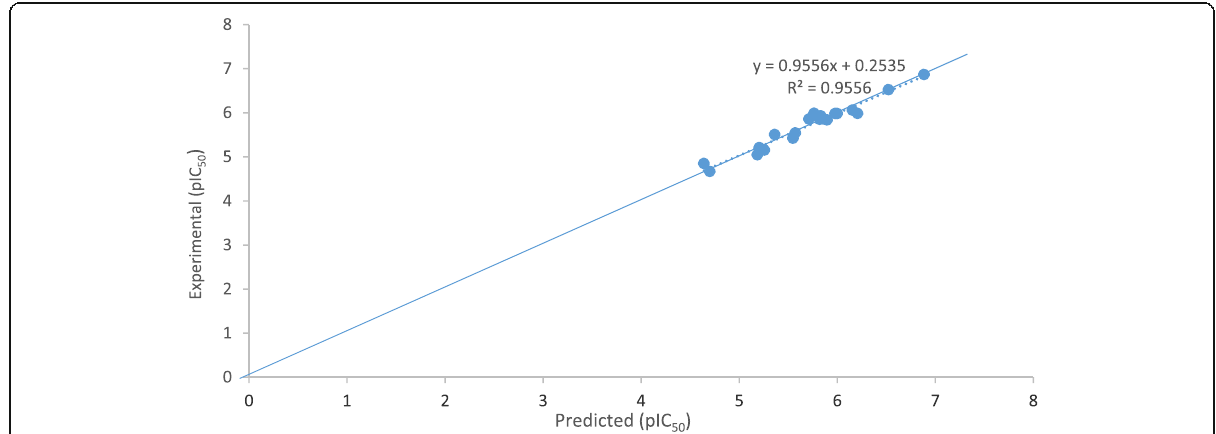
Fig. 3 Illustrating the plot of experimental pIC 50 and predicted pIC 50 value of train set chemical compounds of model